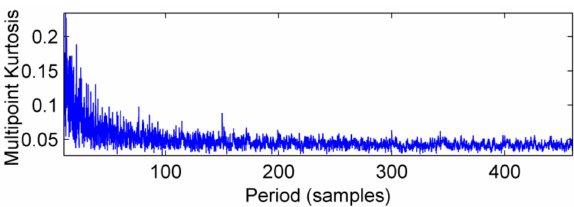
Figure 5. MKurt spectrum of simulation signal under strong